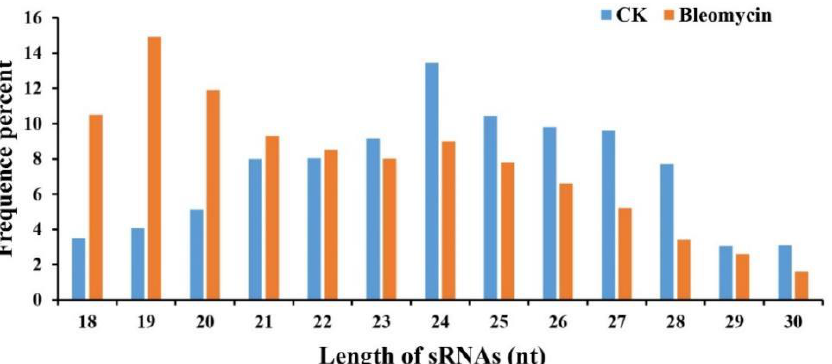
Figure 3. The length distribution of total sRNAs from different groups. Blue box and bars represent the CK (non-treated control) treatment; orange box and bars represent the bleomycin treatment (bleomycin). Y-axis depicts the proportion of reads identified among total reads. X-axis depicts the length of small RNAs. Table 1. Sequencing results of sRNAs derived from two sample libraries.